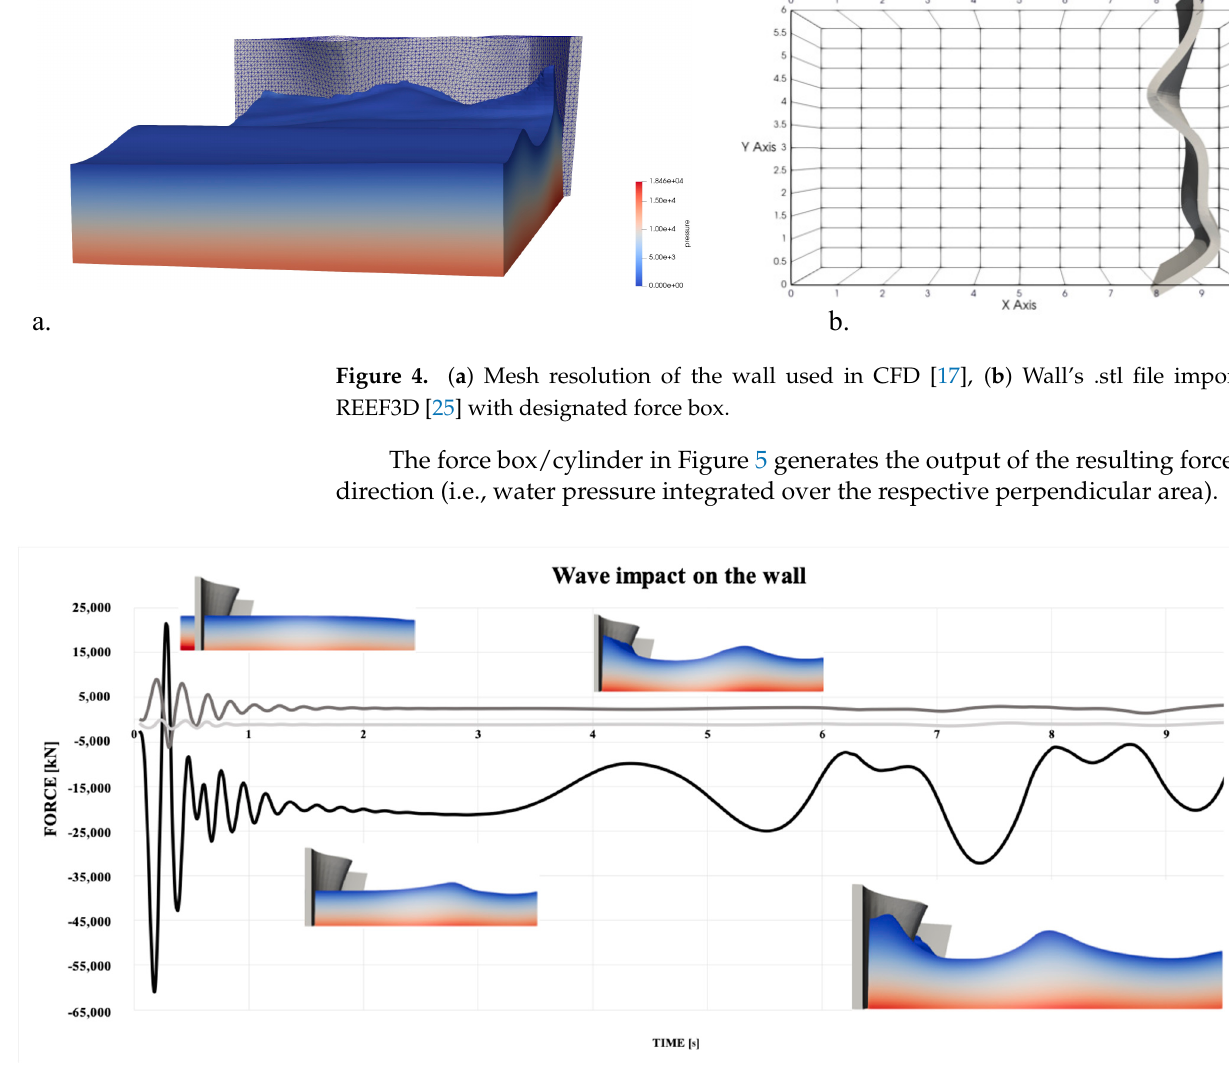
Figure 5. Scenes/screenshots from 10s simulation of water wave reflection by seawall (FLOWall), Load data extraction from CFD model; initial active wave generation is ignored, stabilized data is considered for further design.